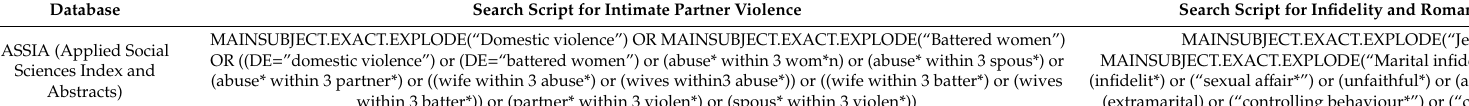
Table A1. Detailed search